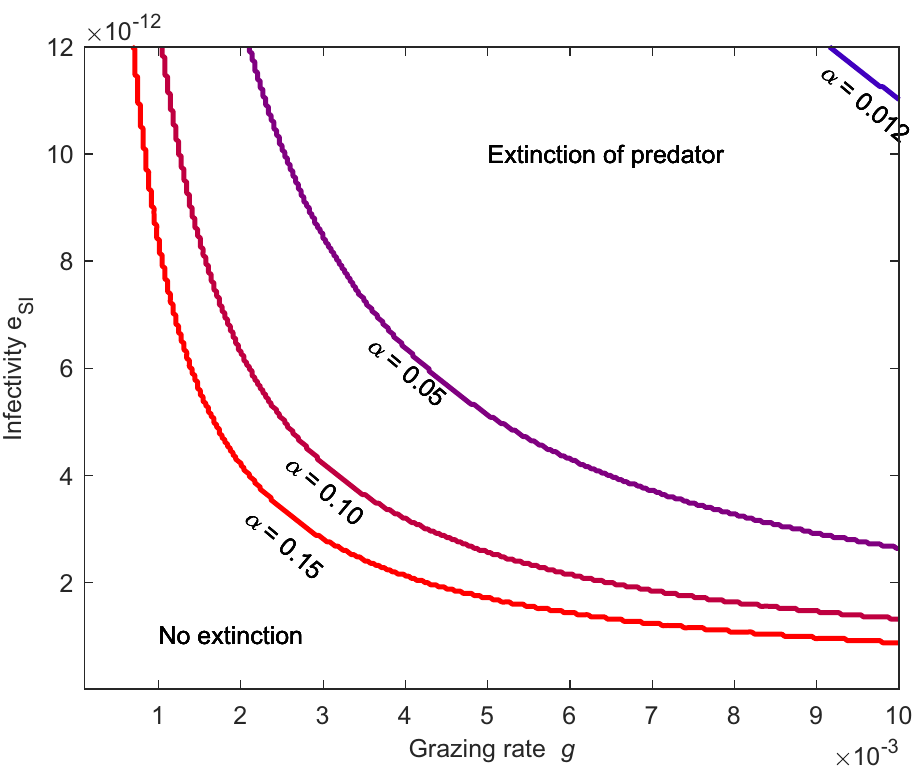
Fig 6. The eradication of the predator by the prey is possible above the lines defining the fraction α of the infective prey. If the infective prey forms a small fraction α of the available prey population, the high prey infectivity e SI and predator grazing rate g are needed to eradicate the predator. To the contrary, if the infective fraction α is large a low infectivity e SI or a low grazing rate g is needed for the predator to prevail. Using the parameters for A . japonicus and V . splendidus the predator survives always if α < 0.011. At very low grazing rate or infectivity the predator does not consume enough infective prey to suffer extinction. Prey growth rate is r C =